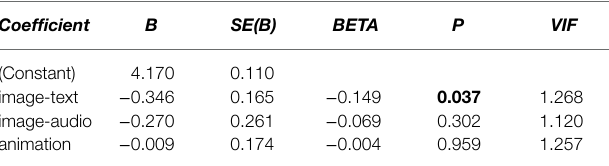
TABLE 11 | Multiple regression between GCL and representation preference ( n = 250).